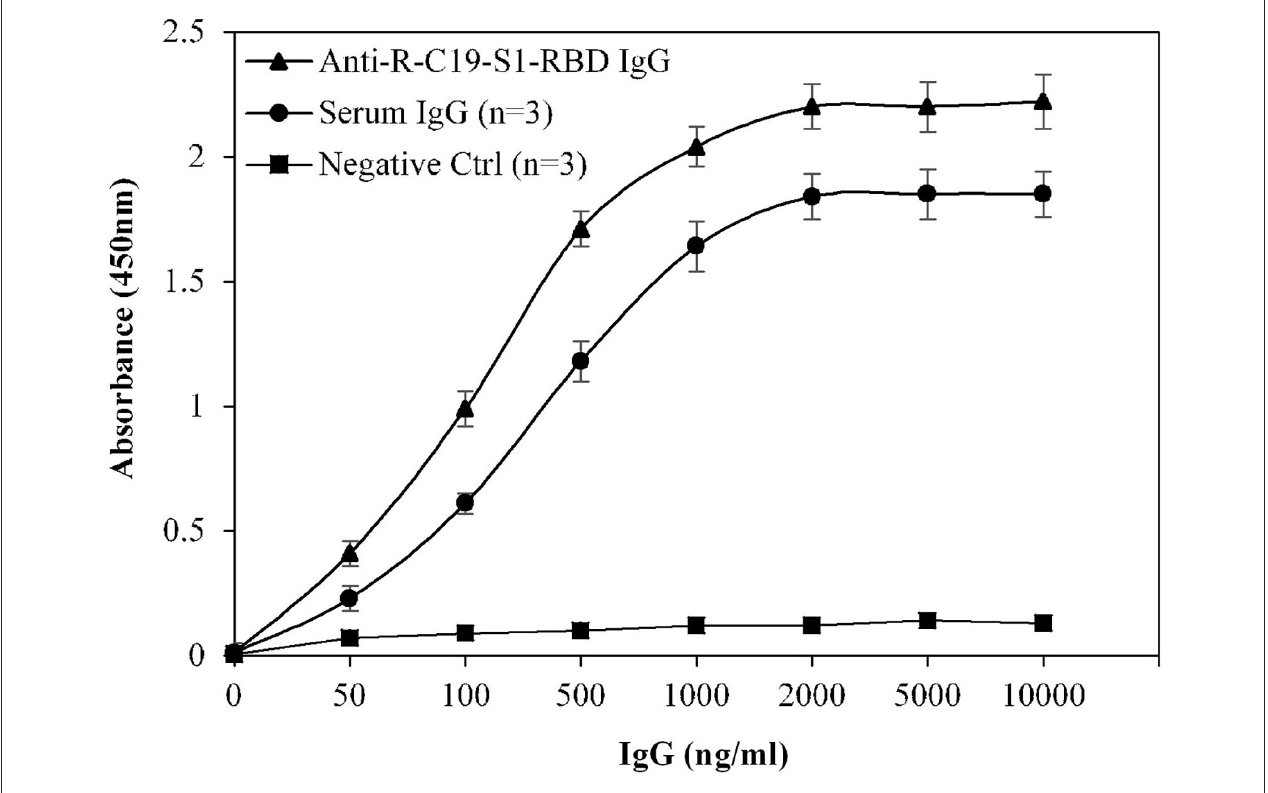
FIGURE 4 | Titration curves for the optimization of serum IgG (COVID-19 patients; n = 3). Commercially available anti-R-C19-S1-RBD IgG was used as a positive control. Three nonreactive serum samples from pre-pandemic subjects served as a negative control. ELISA plates were coated with an antigen (S1-RBD) concentration of 2 µ g/ml. Each sample was run in triplicate under similar conditions.